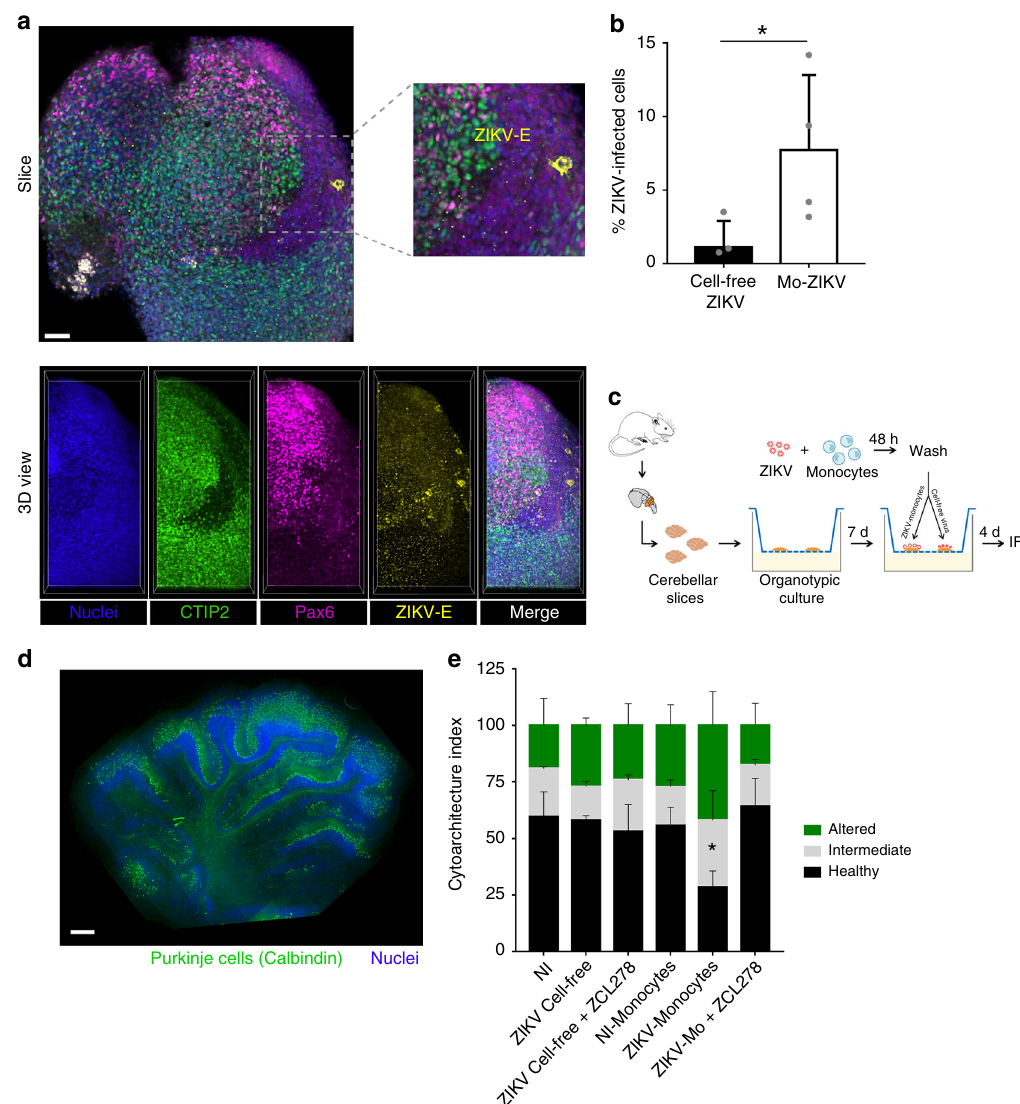
Fig. 3 ZIKV-infected monocytes promote viral dissemination and tissue damage to cerebral organoids. a , b Cerebral organoids of 3 or 5 weeks post differentiation (wpd) were cocultured with ZIKV-infected monocytes, noninfected monocytes, cell-free ZIKV, or mock for 2 days. The organoids were then fi xed and processed for a immuno fl uorescence or b fl ow cytometry. a A slice and the 3D view of the same organoid are shown, which was cocultured with ZIKV-infected monocytes. The crop shows infected cells (not monocytes) in yellow. Scale bar: 50 µ m. b The bar graphs represent the mean of an experiment performed in duplicate ± SD with monocytes from two donors. c – e Organotypic cultures of mouse cerebellar slices were cultured in the presence or absence of cell-free ZIKV or ZIKV-infected monocytes ± ZCL278. c Experimental design. d A staining with an anti-calbindin antibody (green) and Dapi (blue) was done to observe the tissue cytoarchitecture. Scale bar: 500 µ m. e The cytoarchitecture index is a measurement of the degree of tissue injury. Three categories were de fi ned: healthy (part of the lobule with a regular alignment of Purkinje), intermediate (partially damaged, sparse Purkinje), or altered (absence of Purkinje, impaired on the slice). For each condition, the length of the healthy, intermediate, or altered regions was measured by using ImageJ and the proportion of each category was plotted. The condition in which cerebellar slices were incubated with ZIKV-infected monocytes is the only one that signi fi cantly differed from the others. Two-tailed p value < 0.05 (*). Statistical signi fi cance was determined by using a t test. NI noninfected. Source data in b , e are provided as a Source Data fi